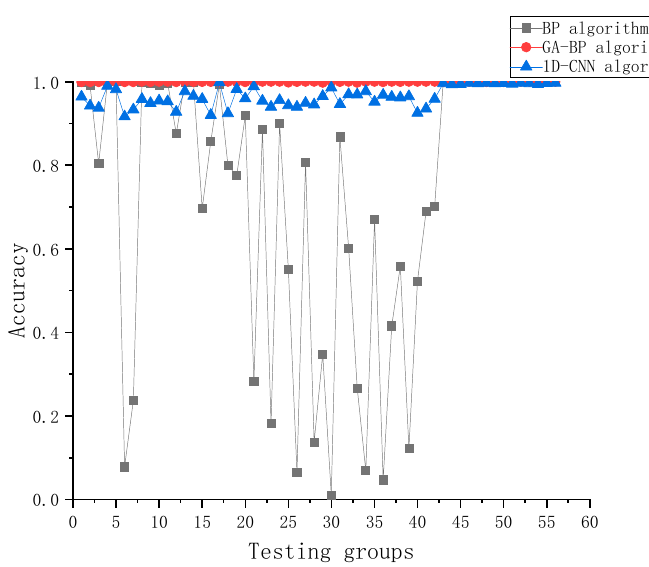
Figure 16. Accuracy of the three